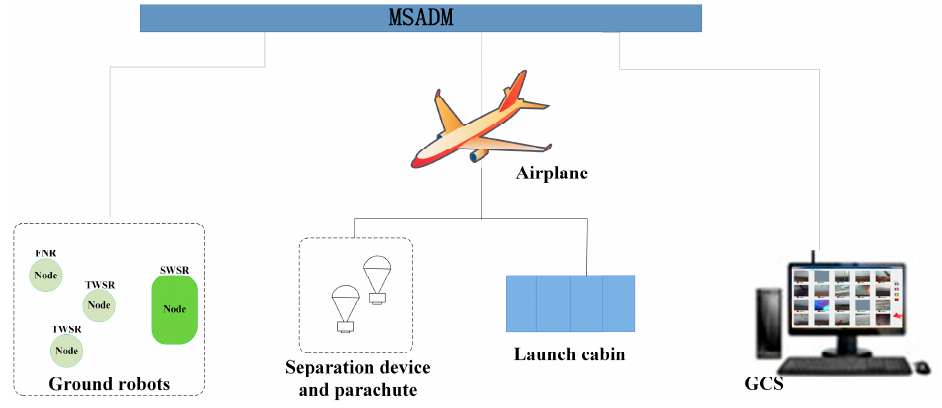
Figure 3. Schematic diagram of the MSADM.